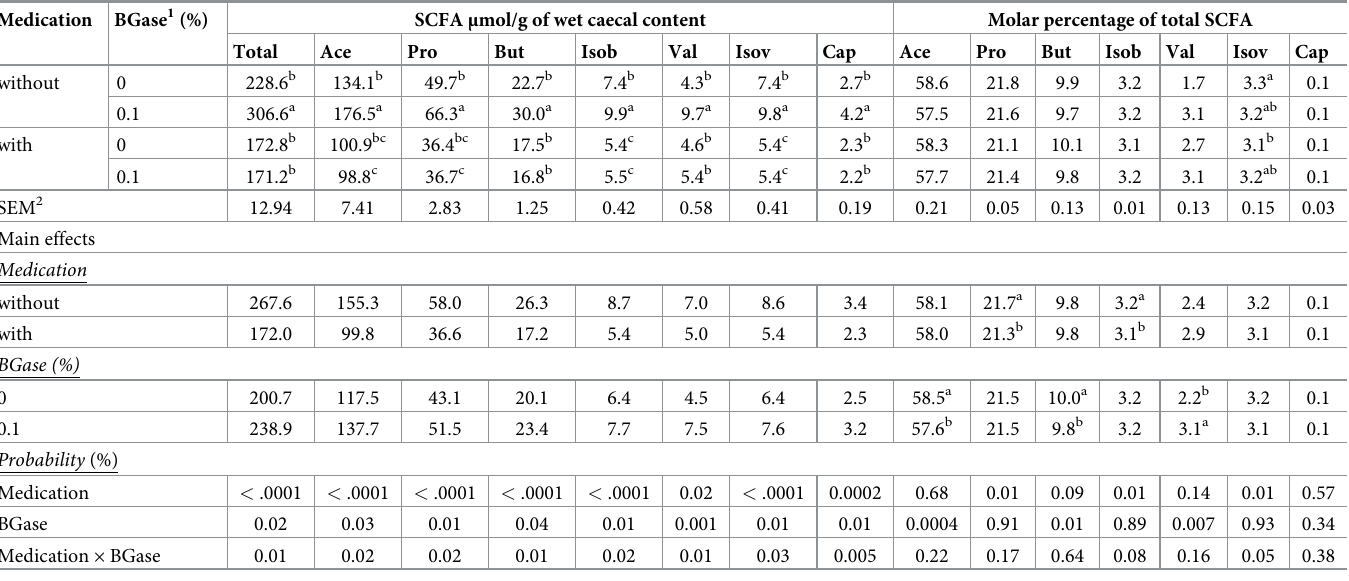
Table 11. Effects of diet medication and β -glucanase on caecal short chain fatty acids of broiler chickens aged 11 days (Experiment